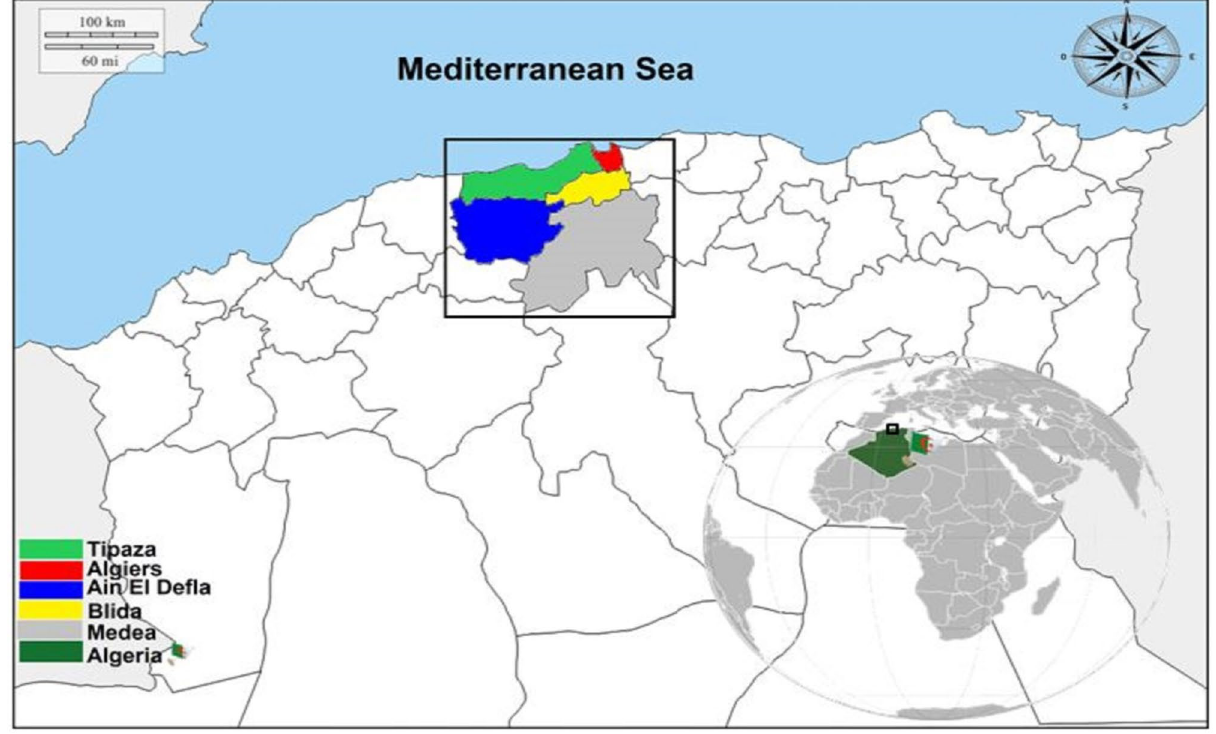
Figure 1. Map of five localities of wild leporids collected in the study area. (The map was generated in paint standard software from a virgin map figure. The map of Algeria is freely accessible at this internet link https://d- maps. com/m/ africa/ alger ia/ alger ienord_ fr/ alger ienord_ fr19.